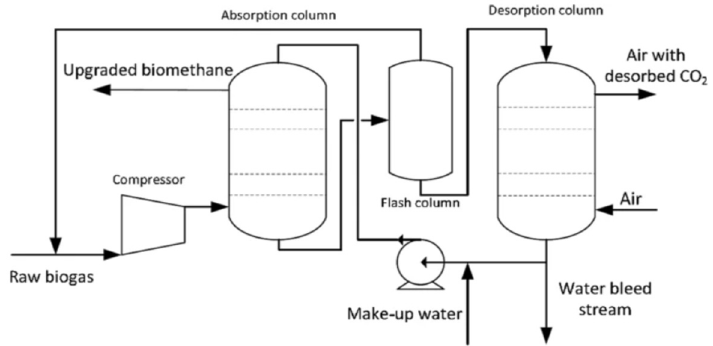
Figure 2. Process flow diagram of water scrubber [31]. Reprinted/adapted with permission from Ref. [31]. Copyright 2022, John Wiley and sons.